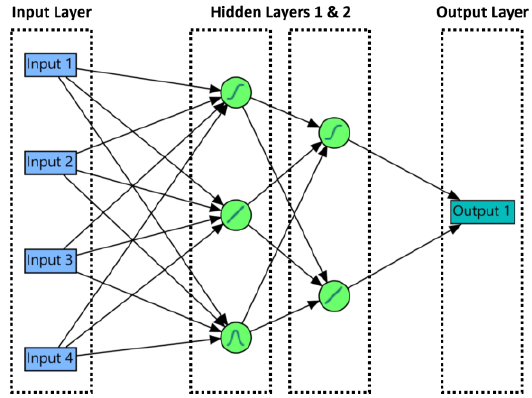
Figure 2. Illustration of a multilayer perceptron ANN model showing the input, hidden, and output layers.